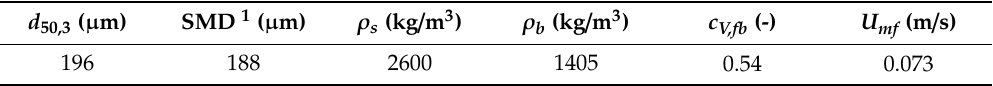
Table 1. Properties of sand particles used in this